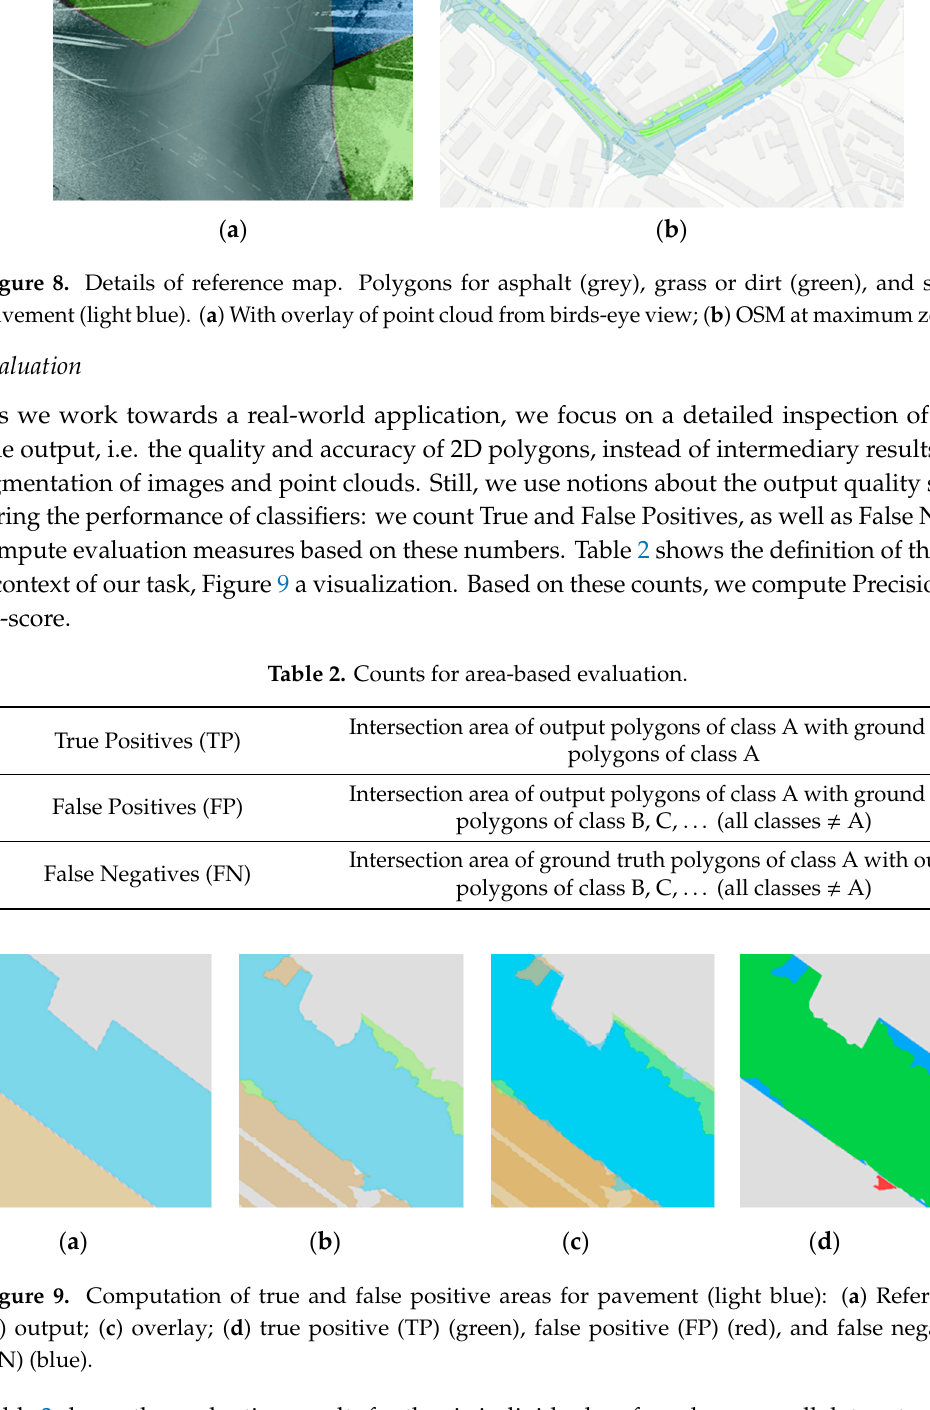
Table 2. Results for all surface classes on all three evaluations sets with size of ground truth data in m2 for each class. Note that the ground truth sizes for three classes (concrete, large paving, and gravel) is very small on the Freiburg set, and the numbers are therefore not reliable (indicated in grey font). Object Class